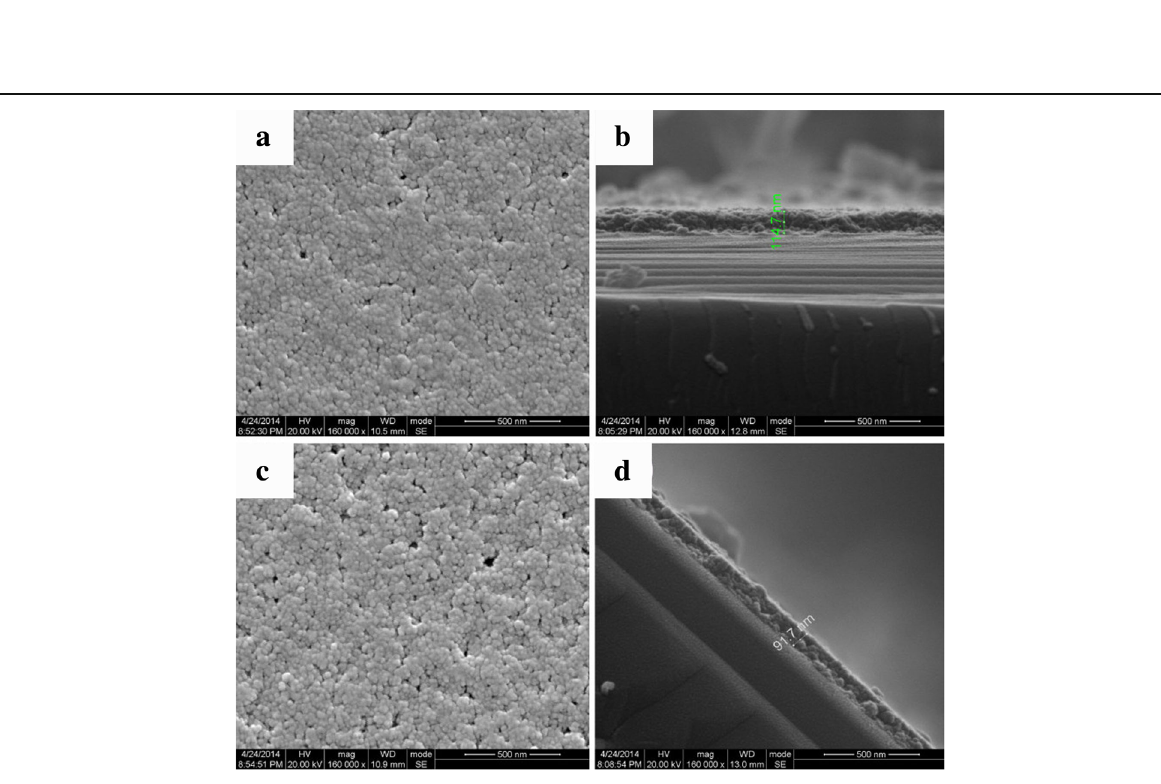
Fig. 4 a SEM images of sol C based single-layer film. b Cross-sectional SEM images of sol C based single-layer film. c SEM images of sol D based single layer film. d Cross-sectional SEM images of sol D based single layer